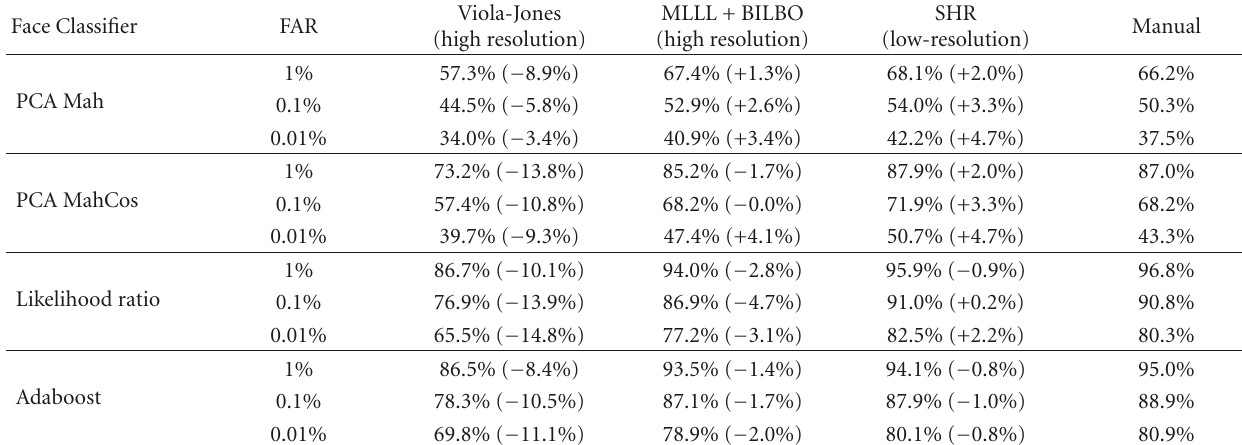
Table 2: Verification rate at FAR = { 1%,0 . 1%,0 . 01% } and in parenthesis the relative contribution that automatic registration has in comparison with manual registration on FRGC [4, Experiment 2 . 1], comparing all registration methods using all face classifiers. The registration.